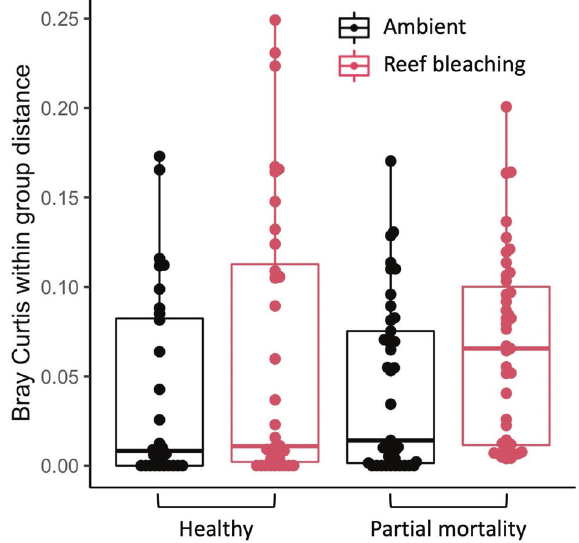
Fig. 6 Dispersion (within group distances) of dinoRNAV mcp aminotypes from Porites lobata-Cladocopium C15 colonies varied by thermal stress timepoint and colony health trajectory on the reefs of Moorea, French Polynesia (South Paci fi c). Dispersion was overall higher in samples collected during reef bleaching time- points. August 2018 and October 2020 samples were grouped as ambient temperature timepoints; March and August 2019 were grouped as “ reef bleaching ” related timepoints since they fell at the beginning and end of the bleaching event in Moorea. Colonies were grouped according to their health trajectory over the sampling duration (colonies that did not exhibit partial mortality- ‘ healthy ’ vs. colonies that did- ‘ partial mortality ’ ). Colonies with ambiguous health trajectories were